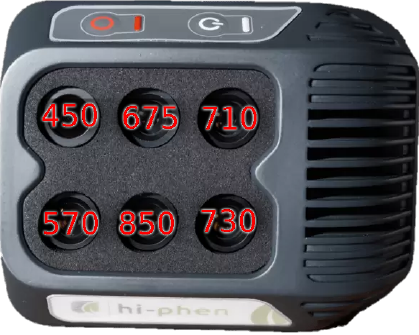
Figure 1. AIRPHEN camera composed of 6 sensors